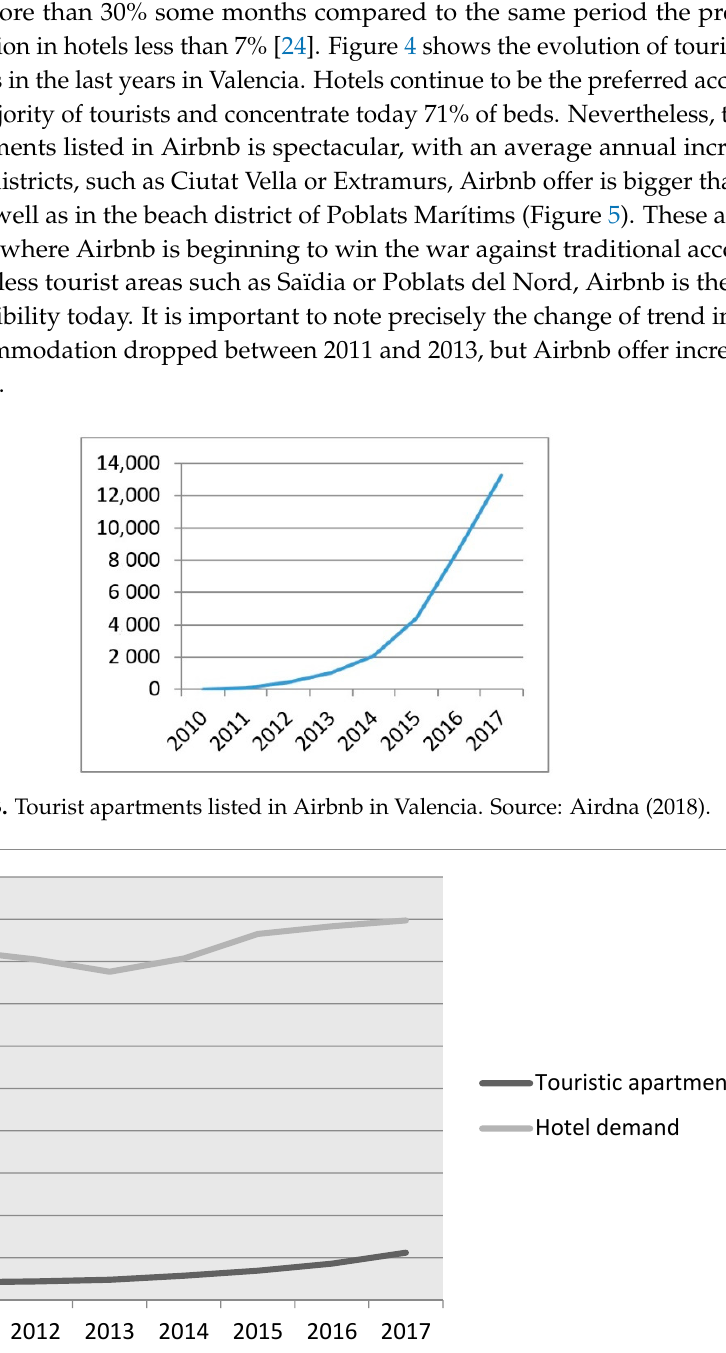
Figure 4. Evolution in tourist demand in Valencia in hotels and tourist apartments. Source: [24].